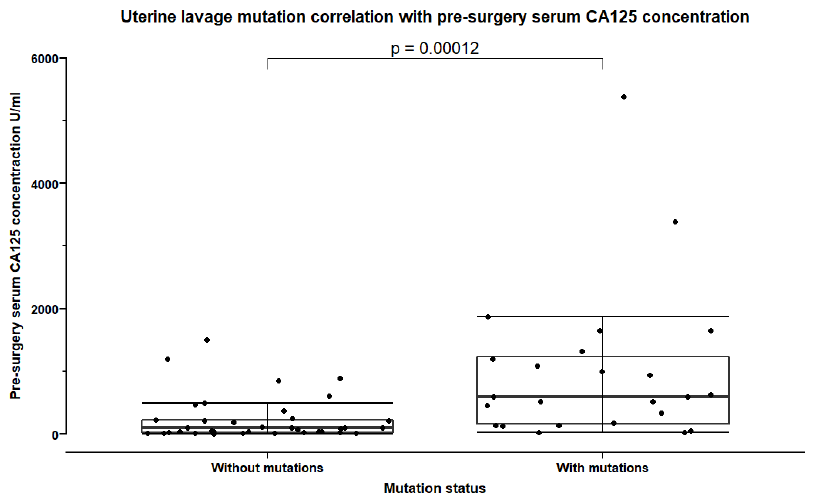
Figure 4. Pre-surgery serum CA125 concentration in patients with and without detected mutations in uterine cavity lavage samples. Error bars show the mean and standard deviation.